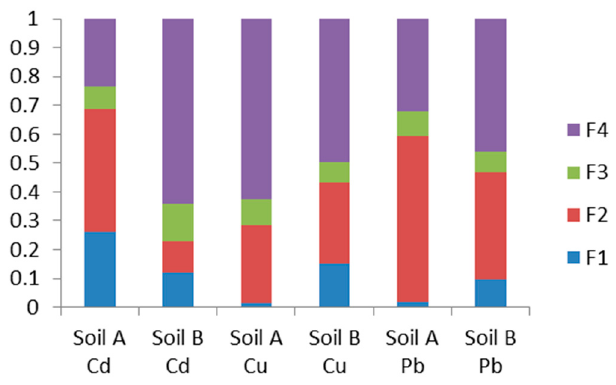
Figure 5. Fractions of Cd, Cu, and Pb in soil A and soil B; F1 = exchangeable acid-extractable fraction, F2 = reducible fraction, F3 = oxidizable fraction, and F4 = residual fraction.